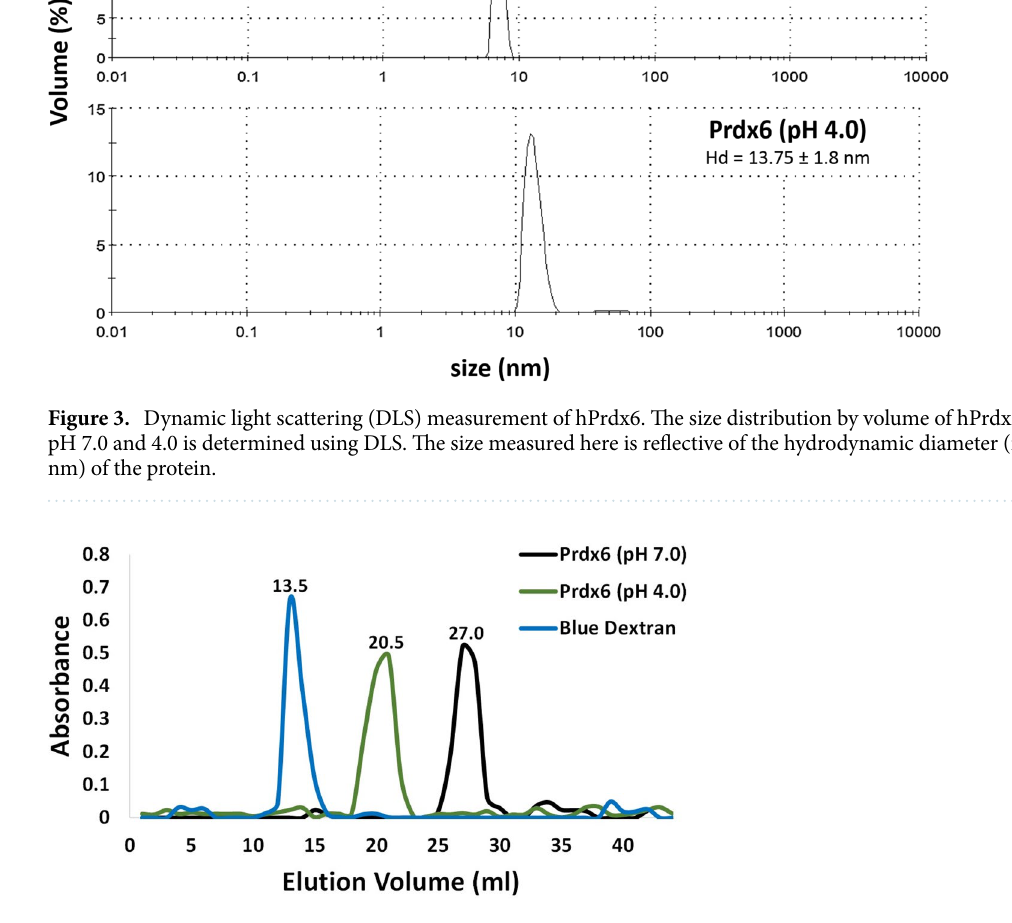
Figure 4. SEC profiles of Human Prdx6 at cytosolic and lysosomal pH. The hPrdx6 (monitored via absorbance measurement at 280 nm) during size exclusion chromatographic analysis was found to elute at 27.0 ml and 20.5 ml at pH 7.0 and pH 4.0, respectively.